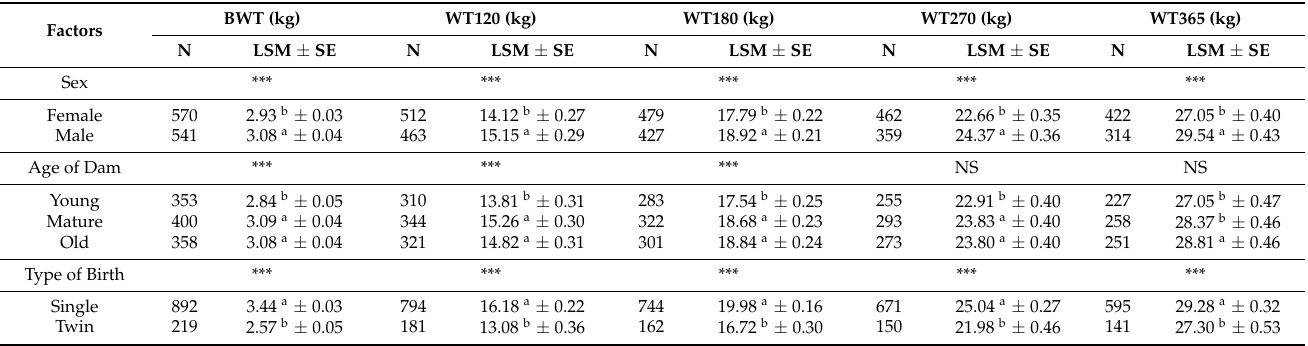
Table 3. Effect of sex, age of dam and type of birth on growth traits of Lohi